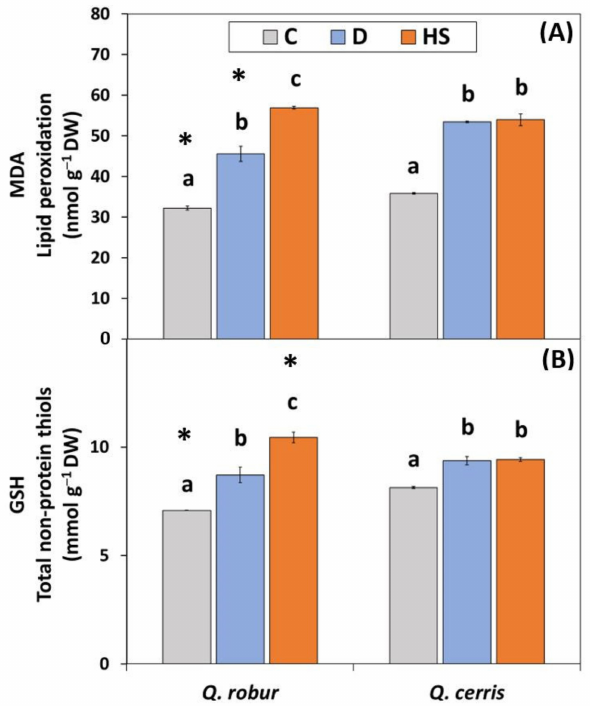
Figure 2. ( A ) Lipid peroxidation measured as levels of malondialdehyde (MDA; nmol g − 1 DW) and ( B ) total non-thiol compounds measured as reduced glutathione (GSH; nmol g − 1 DW) in leaves of Q. robur and Q. cerris . Abbreviations of the treatments, mean separation, and statistical treatments are as shown in Figure 1. Data represent the mean ± standard